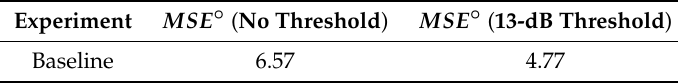
Table 6. Baseline expert-designed system performance